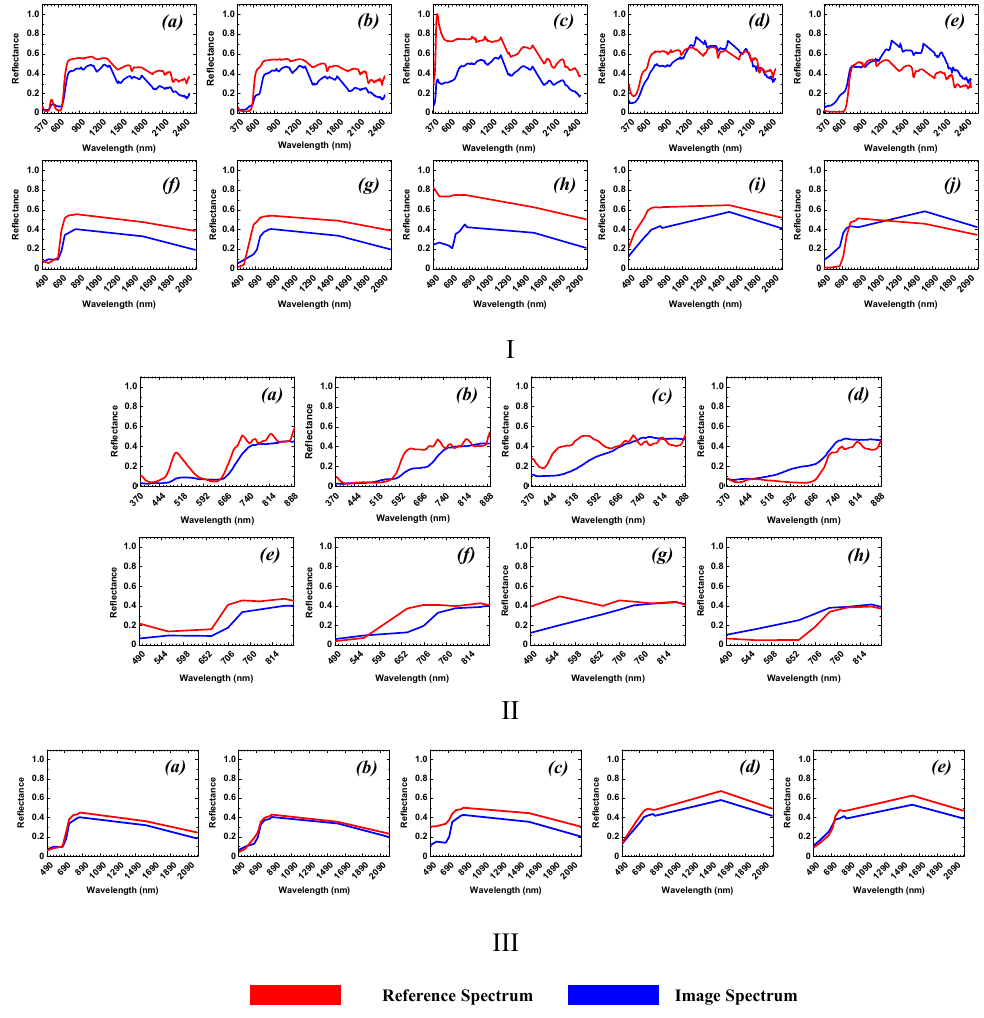
Figure 19. Spectral comparison of the reference target spectra with the corresponding image target spectra for: (I) in-situ measurements of ( a , f ) N1G, ( b , g ) N2R, ( c , h ) C1W, ( d , i ) N3Y, and ( e , j ) N4B compared to airborne and space-borne image spectra respectively; (II) THI measurements of ( a , e ) N1G, ( b , f ) N2R,( c , g ) N3Y, and ( d , h ) N4B compared to airborne and space-borne image spectra respectively;and (III) airborne measurements of ( a ) N1G, ( b ) N2R, ( c ) C1W, ( d ) N3Y, and ( e ) N4B compared to space-borne image spectra. Table 2. Spectral similarity measures between the point-based in-situ target reference spectra and the corresponding airborne, and space-borne target image spectra (spectral angle (SA) is measured in degrees and spectral gradient angle (SGA) in radians) Values in bold are statistically significant.